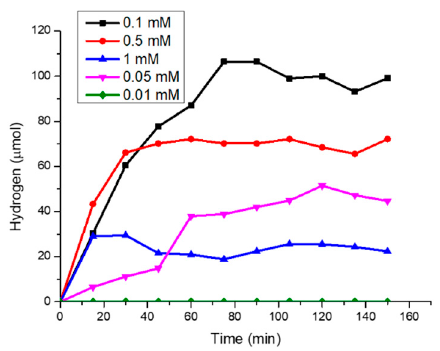
Figure 6. Comparison of visible light-irradiated hydrogen production of Nafion-coated Pt-TiO 2 ( 2 ) by varying the concentration of SnP 6+ by varying the concentration of SnP 6+ .